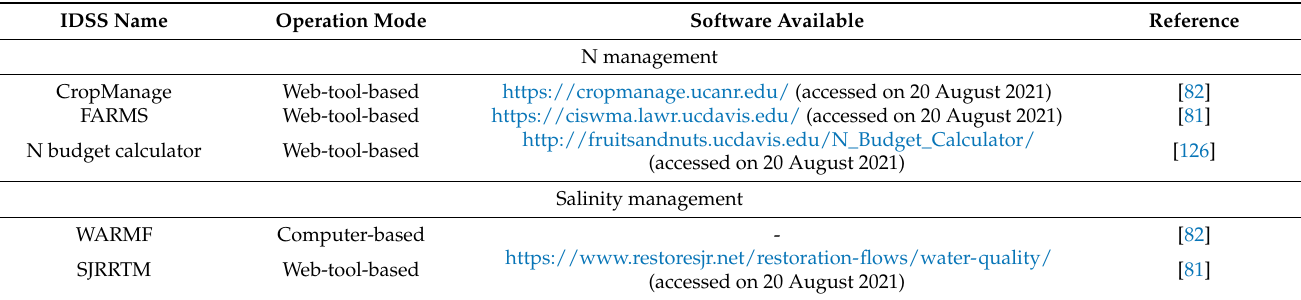
Table 3. Principal decision support systems (DSS) for assisting with nitrate and salinity management of vegetable and tree crops in